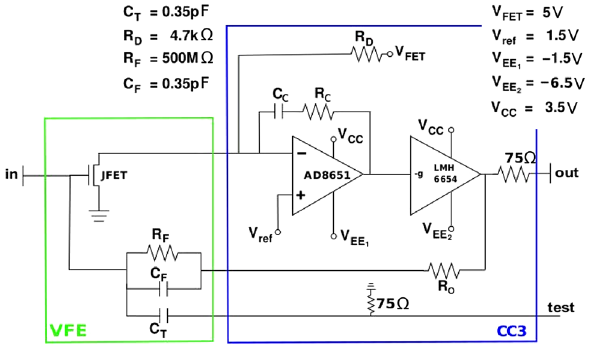
Fig. 5 Schematic of one channel of the CC3 Ge readout circuit. The green frame shows the very front end (JFET, feedback resistor and capacitor), the blue frame the following